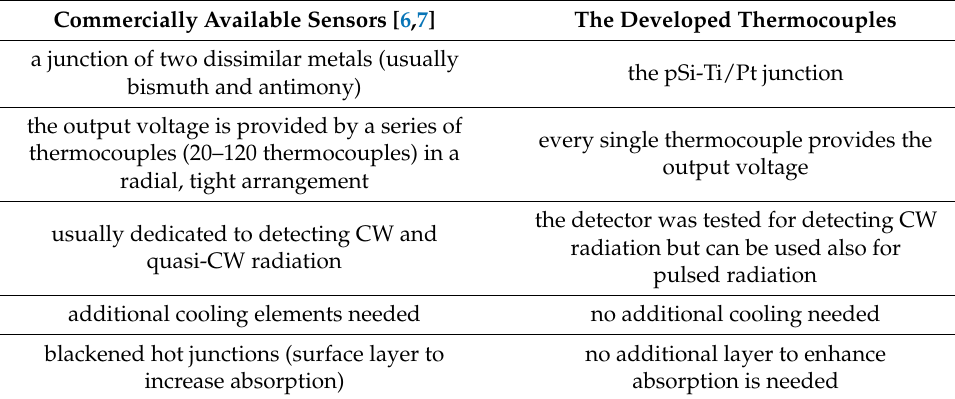
the pSi-Ti/Pt junction every single thermocouple provides the output voltage the detector was tested for detecting CW radiation but can be used also for pulsed radiation no additional layer to enhance absorption is